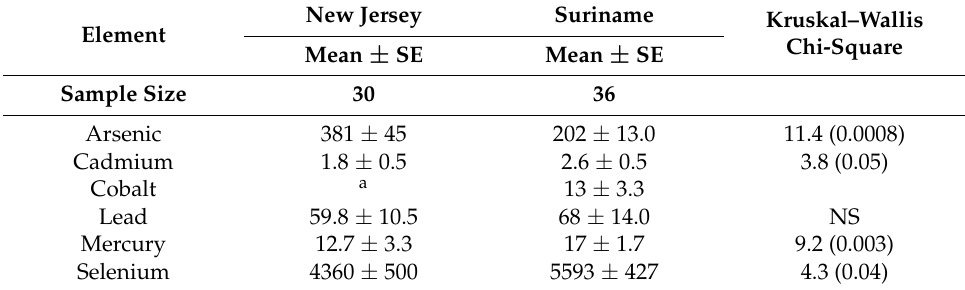
Table 3. Mean element levels in whole blood collected from adult Semipalmated Sandpipers in New Jersey and Suriname. Arithmetic mean values are given in parts per billion (1 ppb = 1 ng/g). NS = not